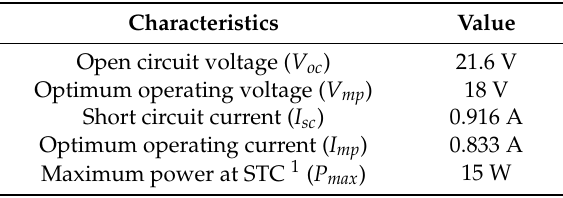
Table 2. Key specifications of the TYUT PV